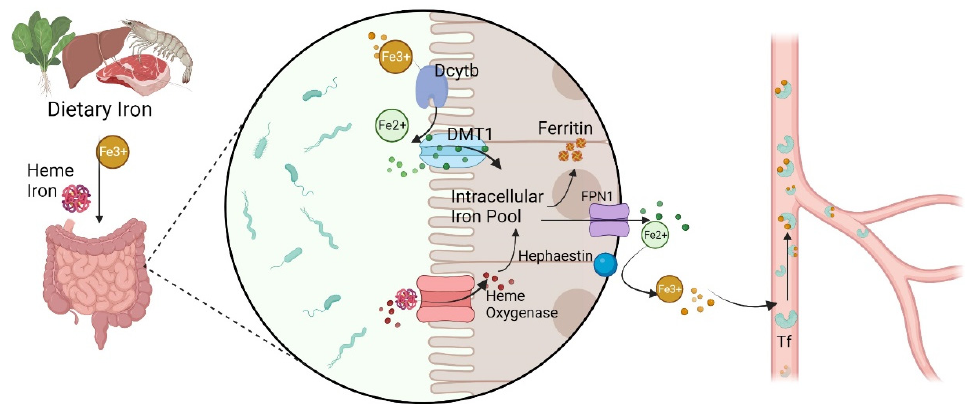
Figure 1. Iron absorption and metabolism in the body. Fe 2+ , ferrous cation; Fe 3+ , ferric cation; Dcytb, duodenal cytochrome b; DMT1, divalent metal transporter 1; FPN1, ferroportin 1.